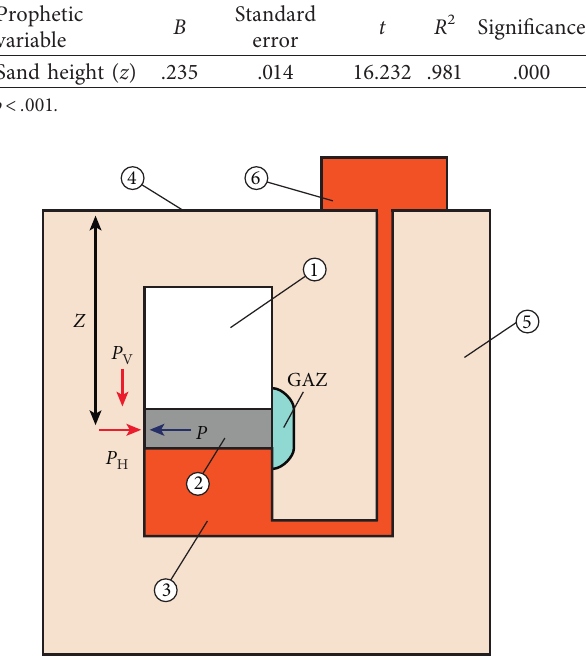
Figure 4: Schematic illustration of lost-foam casting process. 1, expanded polystyrene pattern; 2, kinetic zone; 3, molten metal; 4, flask; 5, dried sand; 6, pouring basin; P , gas pressure in kinetic zone; z , height from kinetic zone to sand; P V , vertical sand pressure; P H, horizontal sand pressure; GAZ, gas affected